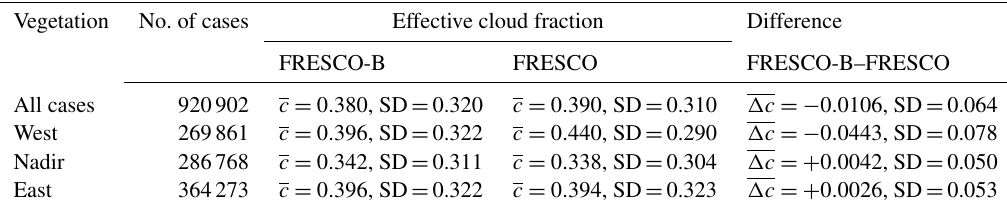
Table 3. Mean effective cloud fractions and standard deviations for FRESCO-B and FRESCO, as well as the mean difference, for GOME-2B measurements in July 2014 over vegetation. We distinguish the eastern (pixels 1 to 8), nadir (pixels 9 to 16) and western (pixels 17 to 24) parts of the swath.